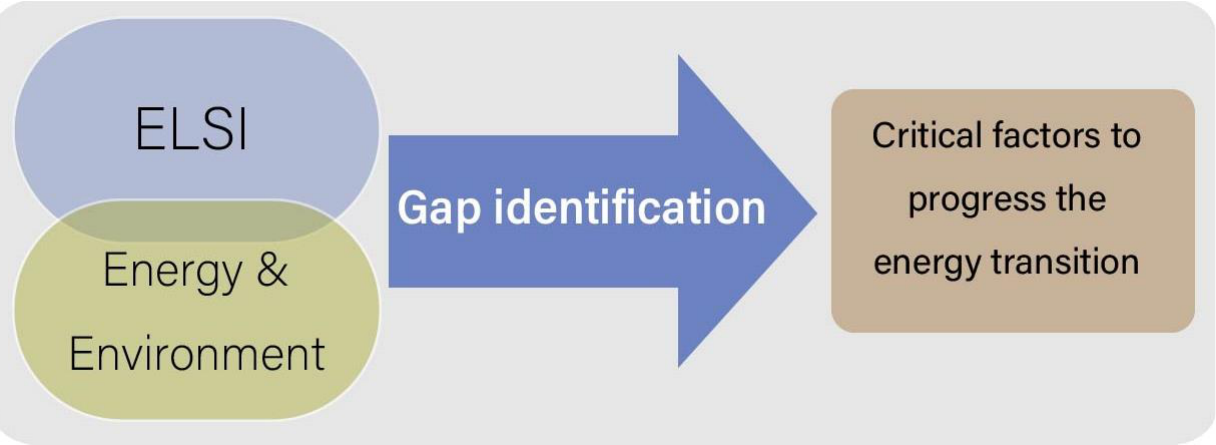
Figure 1. Research Focus and Desired Outcomes.